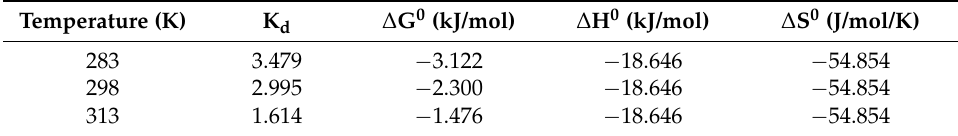
Table 2. Thermodynamic parameters for the adsorption of BPA by GO.